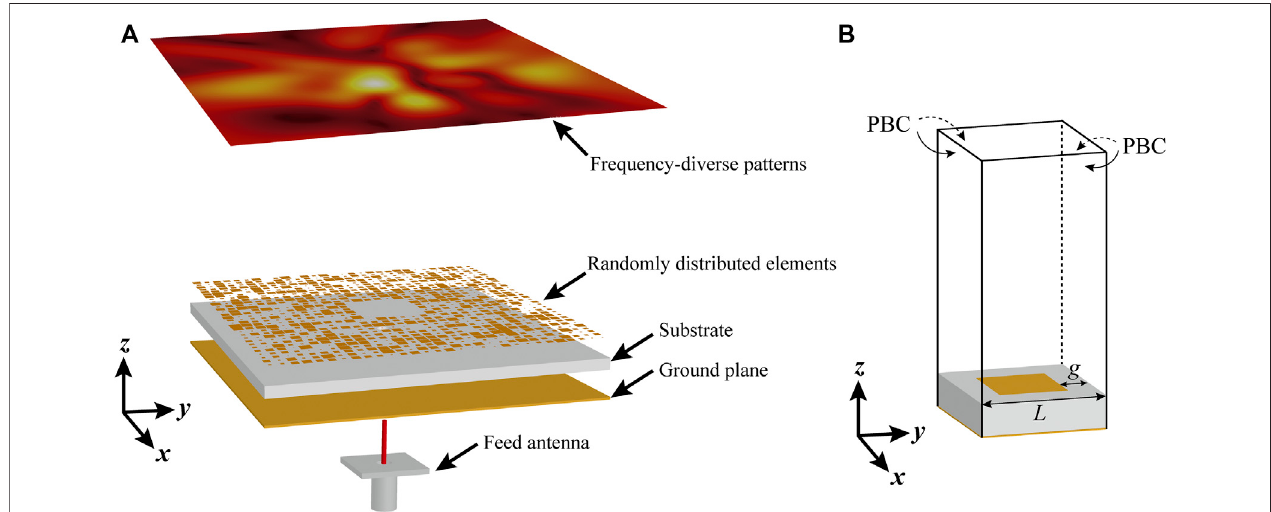
Frontiers in Materials |